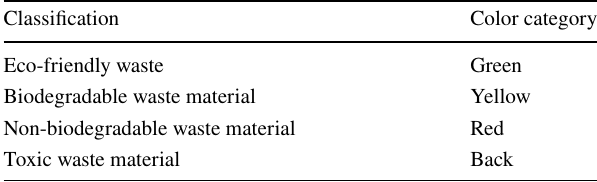
Table 4 Color classification test procedure used to determine if a material is biodegradable, recreated after Bertram et al. 2018)